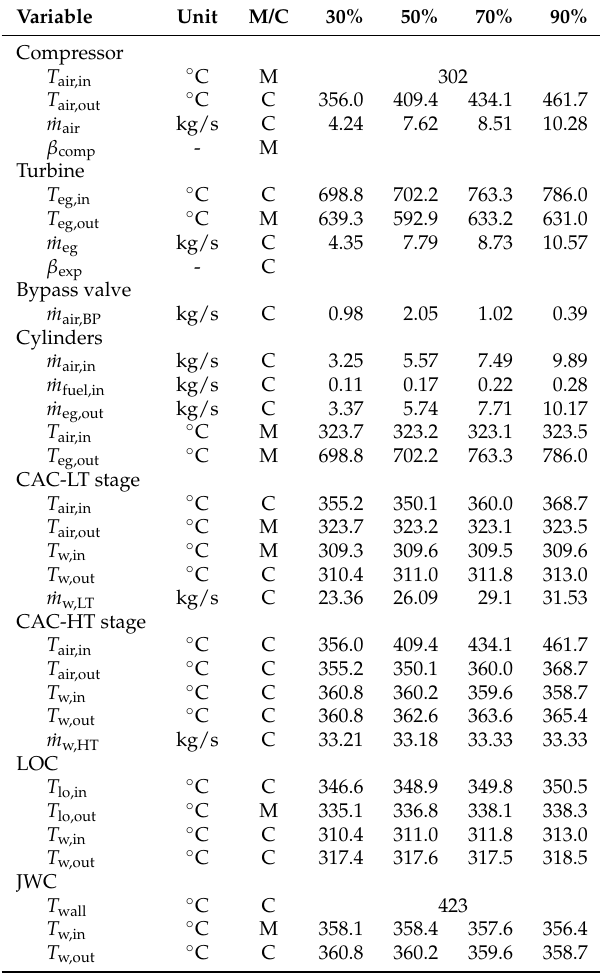
Table A1. Main engines, measured and calculated temperatures and flows at different engine